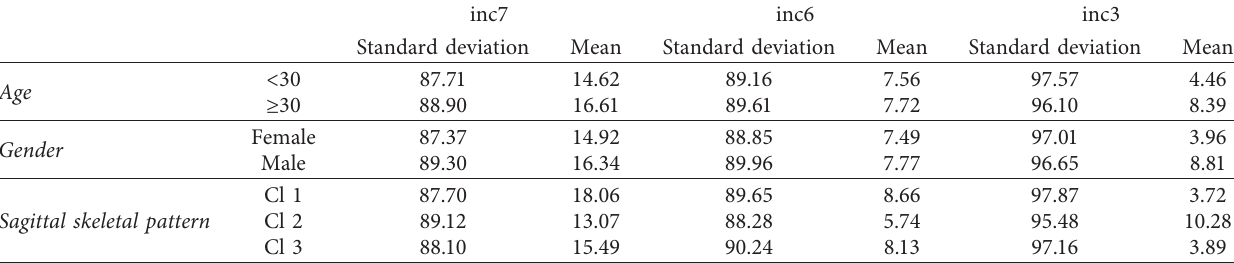
Table 5: Mean inclination of teeth based on demographic variables of